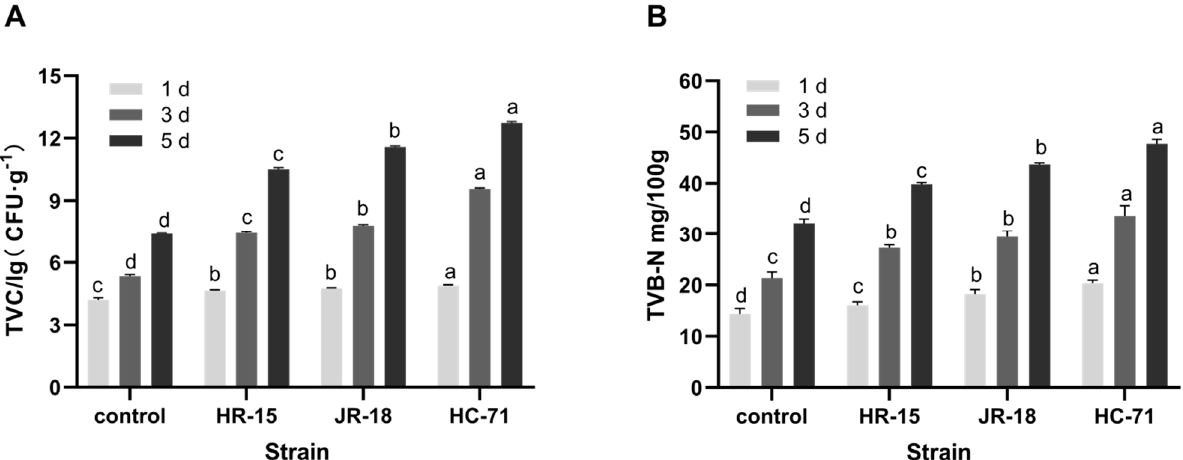
Figure 2. The changes in the total viable counts (TVC) ( A ) and TVB-N ( B ) of the fish fillets inoculated with three S. putrefaciens strains (HR-15, JR-18, and HC-71) stored at 4 °C. Different lowercase letters indicate significant differences at the 0.05 level ( p < 0.05). Table 3. The yield factors of the TVB-N of the fish fillets inoculated with different S. putrefaciens strains (HR-15, JR-18, and HC-71) during chilled storage at 4 °C.